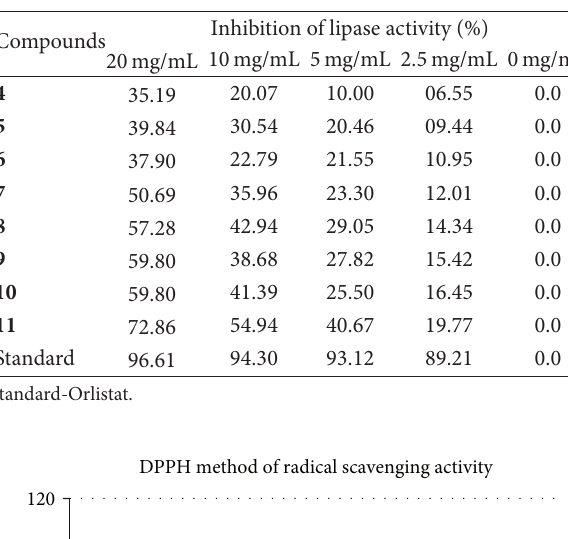
T 6: Pancreatic lipase inhibitory activity of compounds 4–11 .